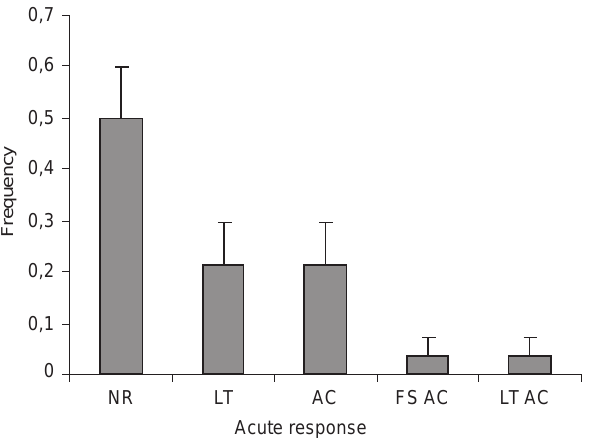
Figure 4. Frequency of no responses (NR) and observed responses (LT = lobtailing, AC = acceleration, FS AC = fast submersion fol- lowed by acceleration, and LT AC = lobtailing followed by accel- eration) executed by the humpback whales immediately after tag- ging (acute